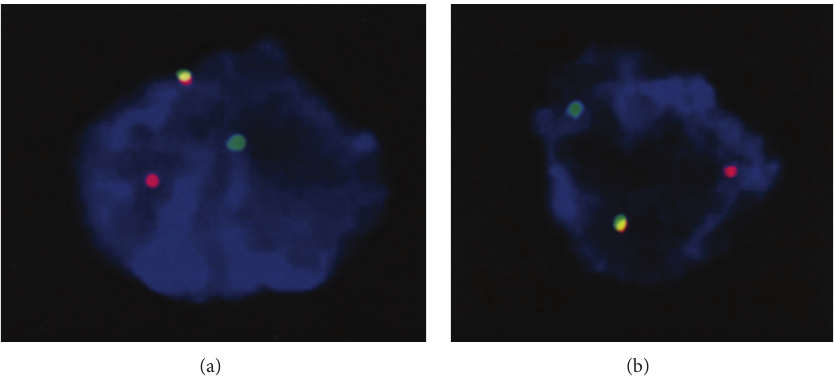
Figure 3: FISH analysis using dual color ALK break apart probe of the liver (a) and lumbar lesions (b) showing abnormal ALK (2p23) gene arrangement (translocation). (a) and (b) This is a “break-apart” probe system, where the fused red/green (overlap as yellow) represents the normal ALK gene locus and the separated red and green signals represent an underlying ALK rearrangement (i.e., translocation). Interphase FISH analysis of at least 200 interphase nuclei was performed with a dual color ALK break probe apart set to detect rearrangement of the ALK locus that is commonly associated with anaplastic large cell lymphoma. The break-apart signal pattern (1R1G1F, one red, one green, and one fusion signal) was observed in 11.5% of the analyzed nuclei in the liver (a) and in 12.5% of the analyzed nuclei in the lumbar spine (b). The normal reference is 1.7%, and as such, this represents an abnormal result indicative of ALK gene rearrangement with an unknown chromosomal